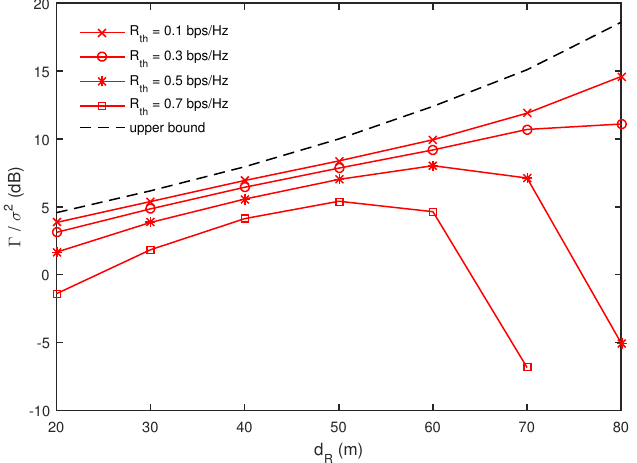
Figure 3. Comparison of minimum harvested energy as a function of d R for different values of R th when M = 4 and I = J = K =